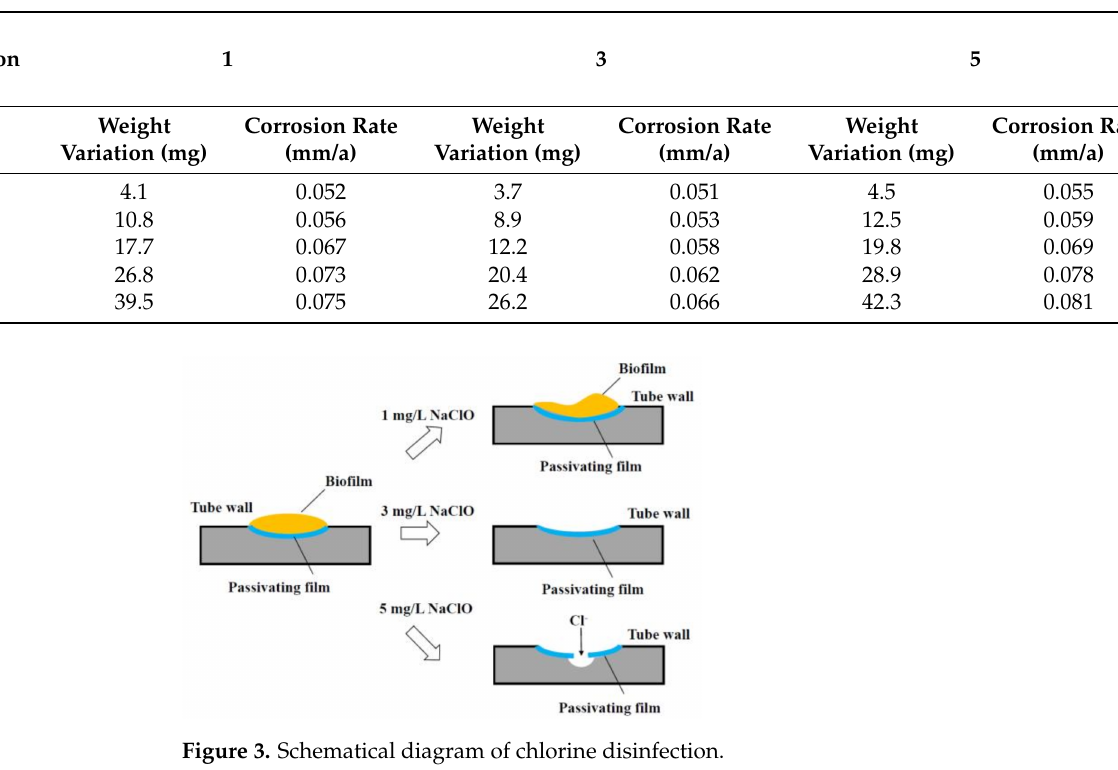
Table 1. Correlation between initial content of residual chlorine and corrosion rate.